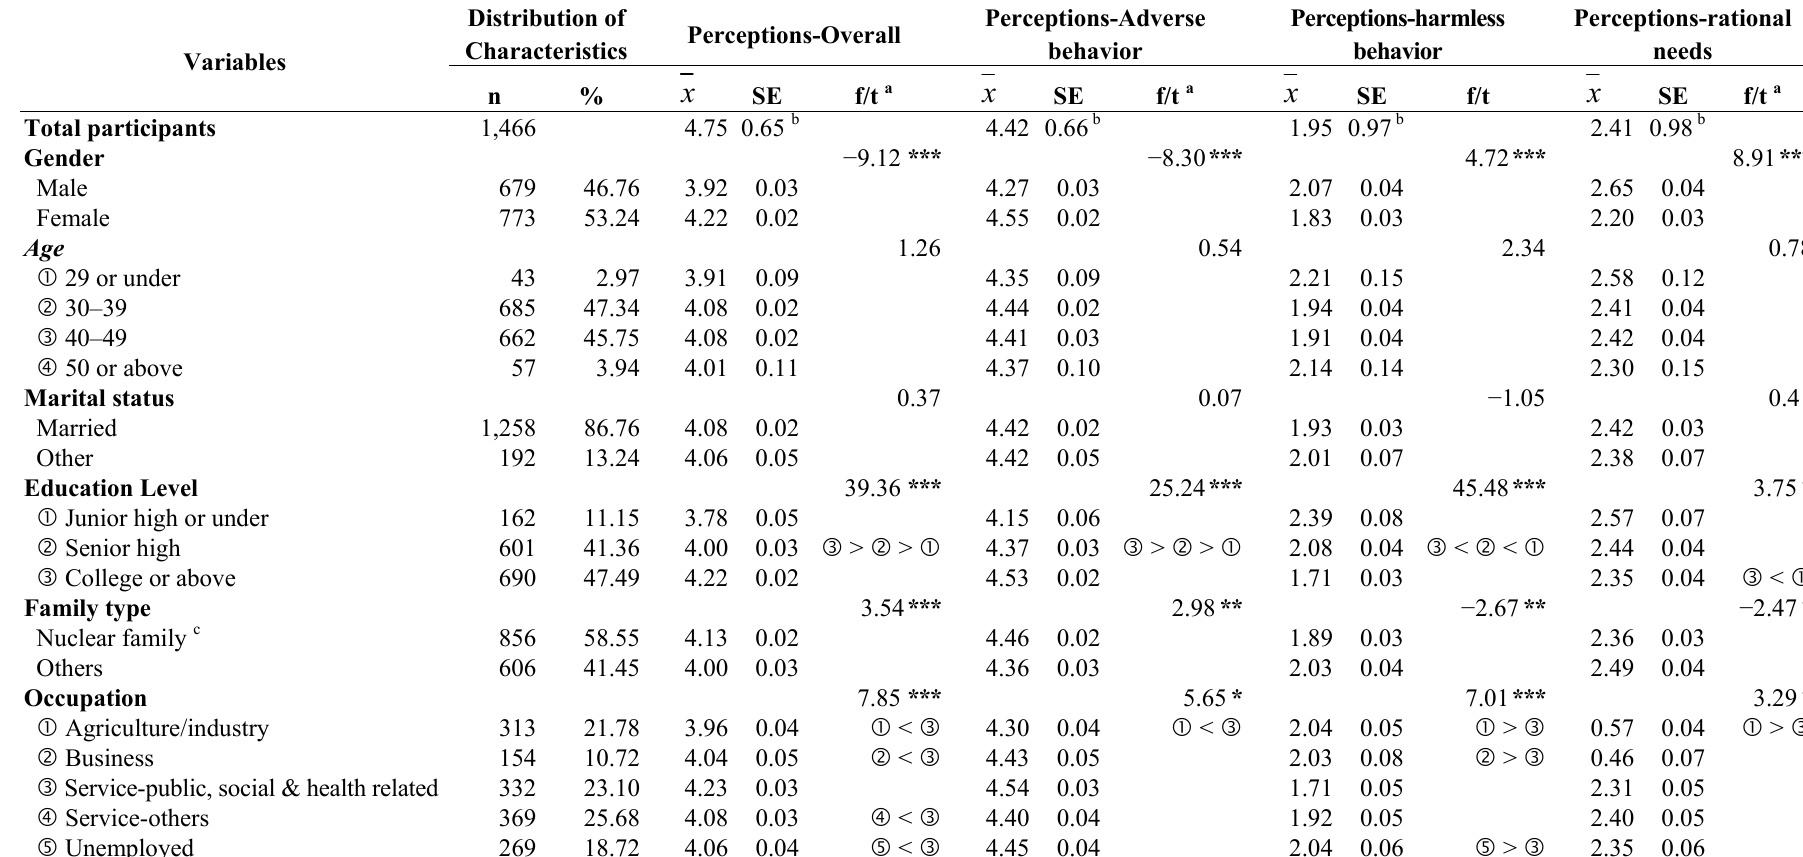
Table 1. Comparison of perceptions of parental smoking in the presence of their children between different sociodemographic characteristics, smoking status, and agreement with having home smoking restriction (N =